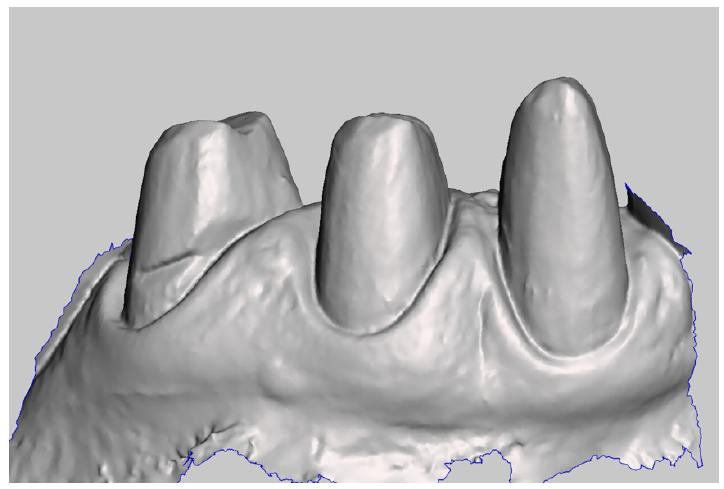
Figure 7. Digital impression of the abutments.